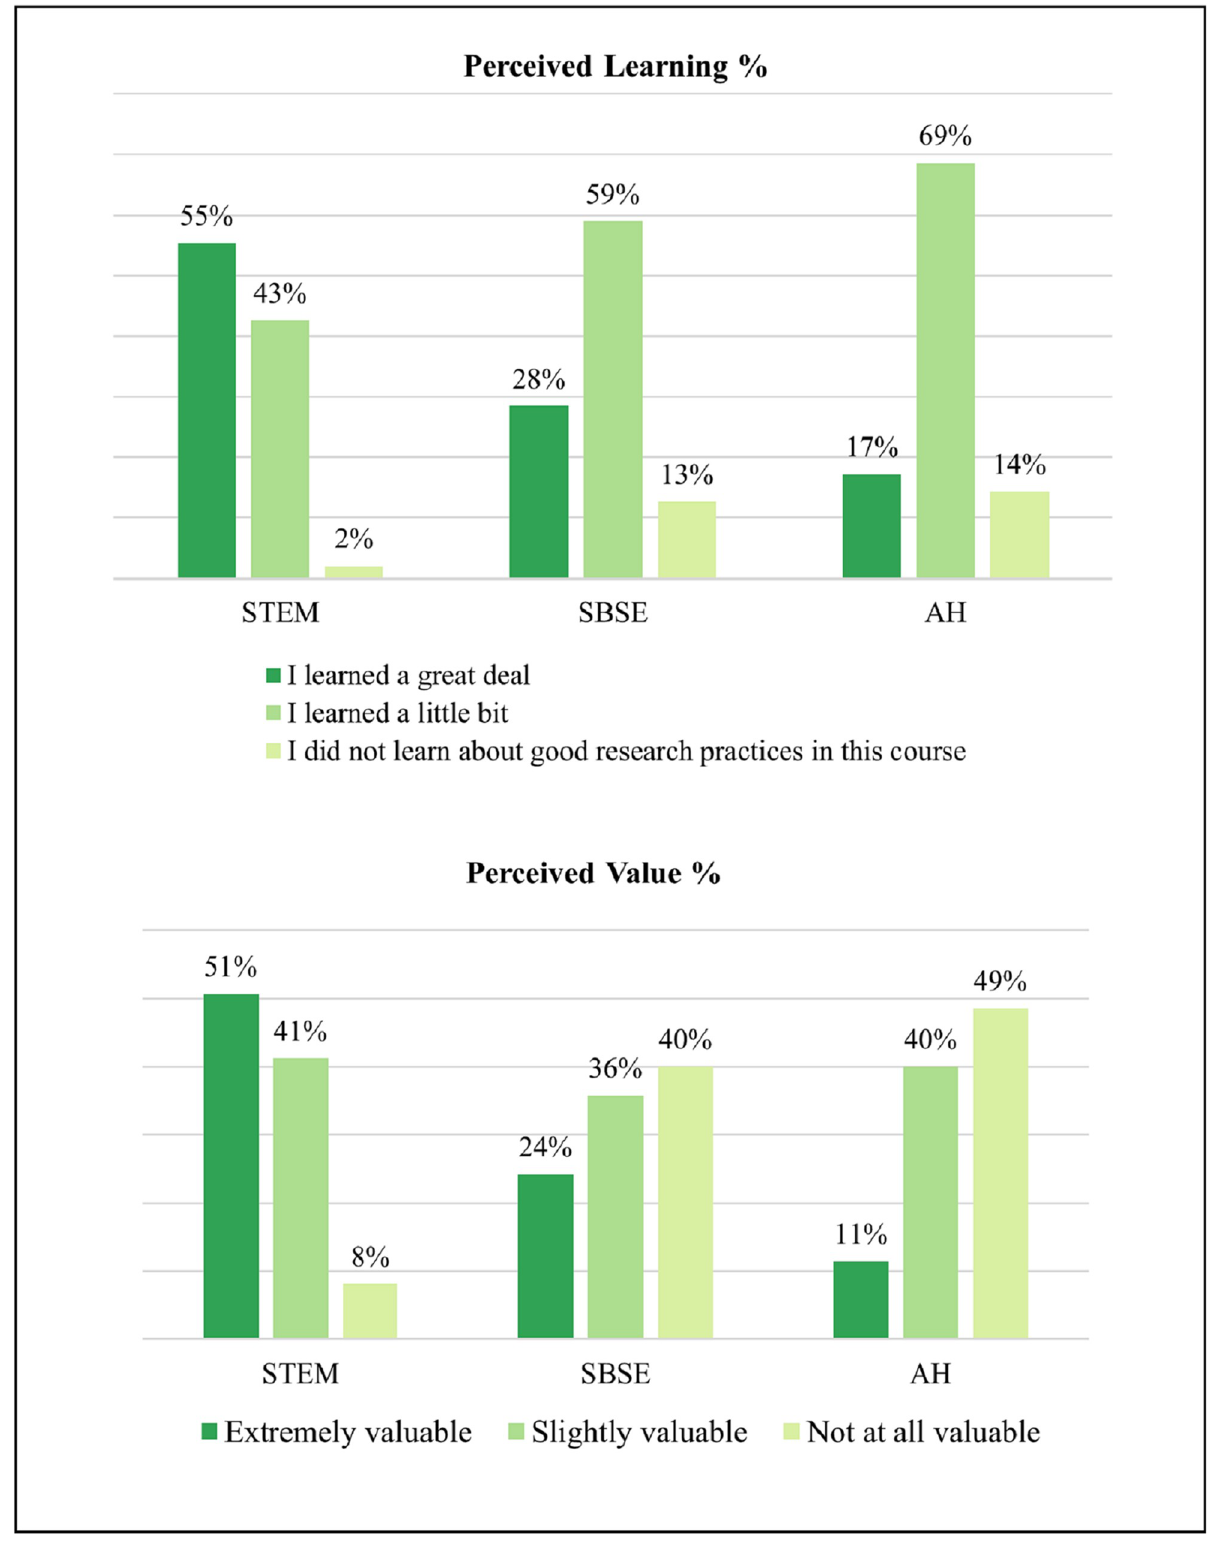
Fig 1. Overall course experience